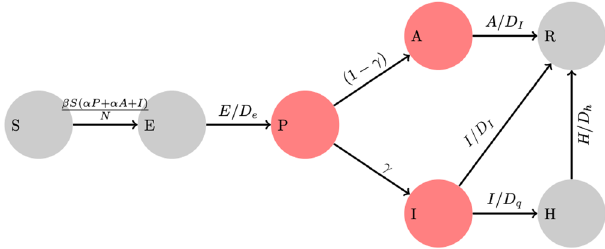
Figure 1. Schematic of the SEPAIHR model. Here we include seven compartments namely: susceptible (S), exposed (E), presymptomatic infectious (P), infectious (I), asymptomatic infectious (A), isolation in hospital (H), and removed (R). Two parameters of interest are γ (documented infection rate, defined as the probability that a patient would be laboratory confirmed) and β (transmission rate, defined as the number of individuals that a documented infected case can infect per day), which are considered to vary across time periods. In this model, the asymptomatic compartment A represents individuals who were not documented but could still transmit the virus to susceptible